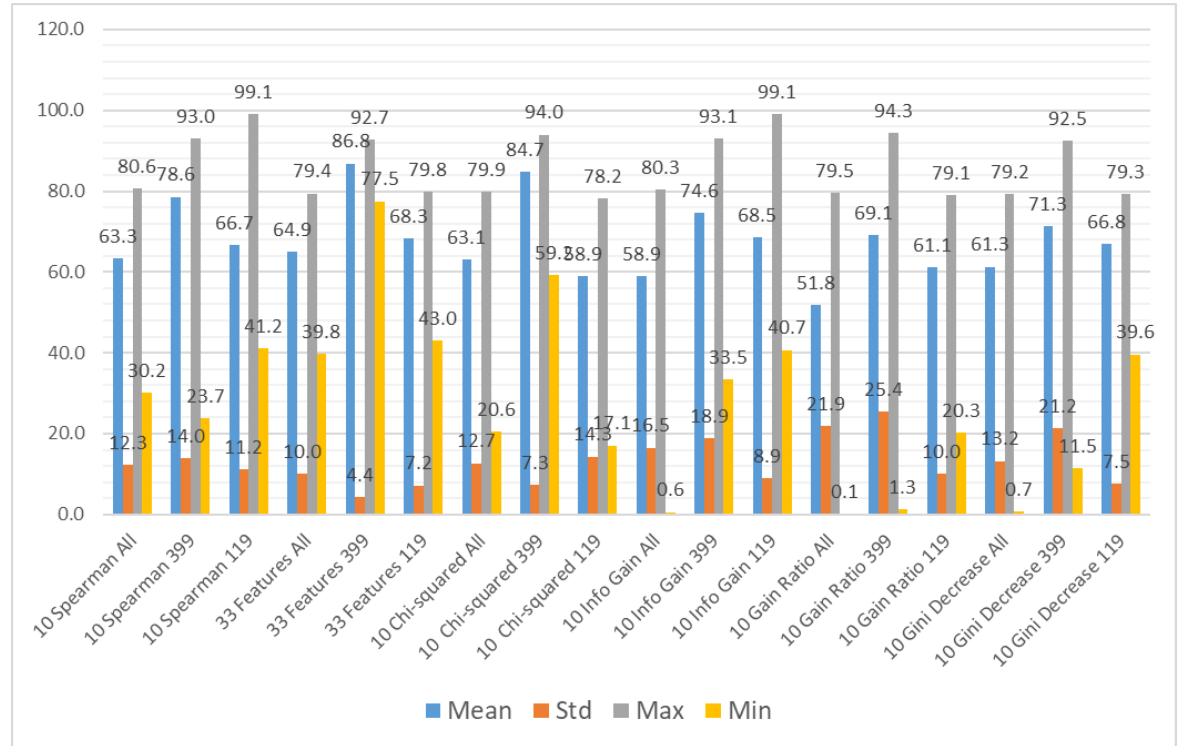
Figure 8. Aggregated recall results grouped by feature subset.